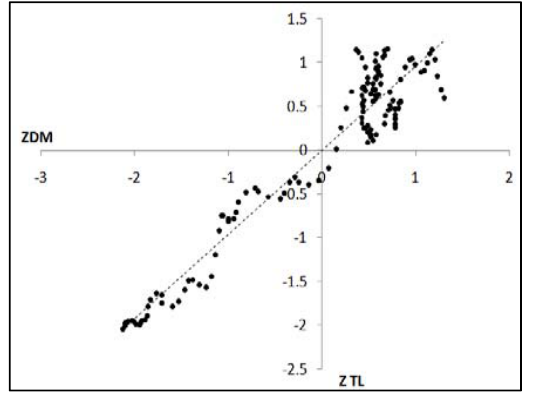
Figure 4. Distribution of TL and DM variables transformation